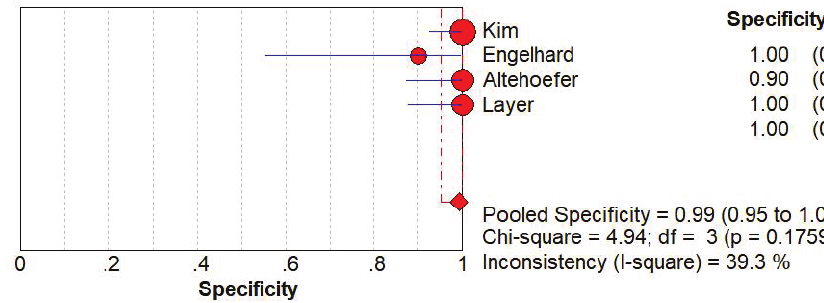
Figure 2: The plot for the sensitivity of MRI